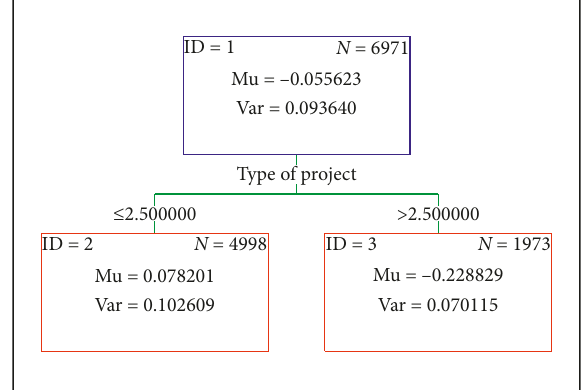
Figure 6: A fragment of ensemble